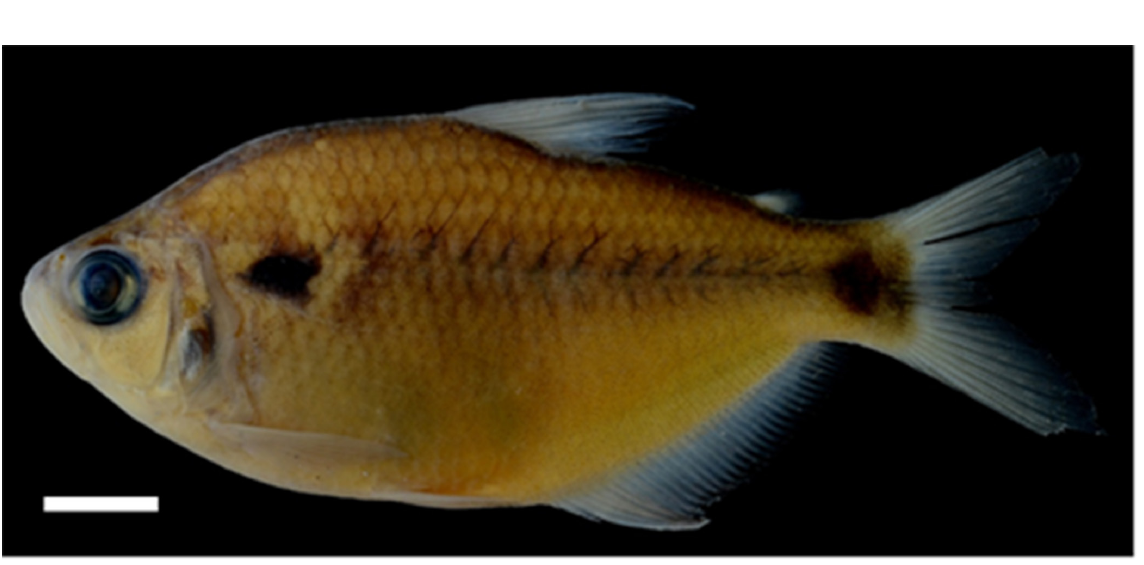
Fig. 12. Astyanax yariguies ( Torres-Mejía, Hernández & Senechal, 2012 ) comb. nov., paratype, 75.5 mm SL, La Concordia Creek, Santander, Colombia (ICNMNH 17642). Scale bar = 1